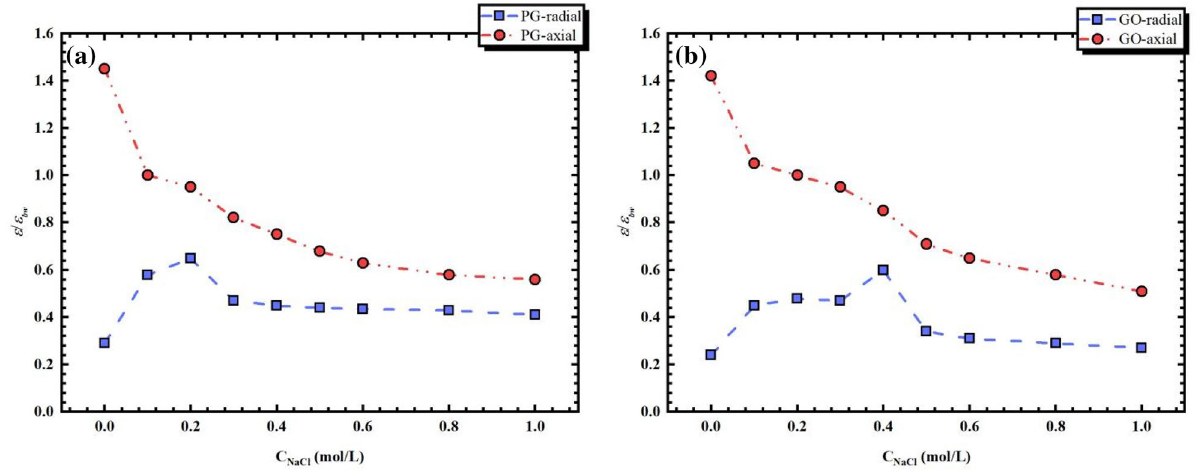
Figure 3. Dielectric permittivity of NaCl solution in both PG and GO graphene bilayers as a function of salt